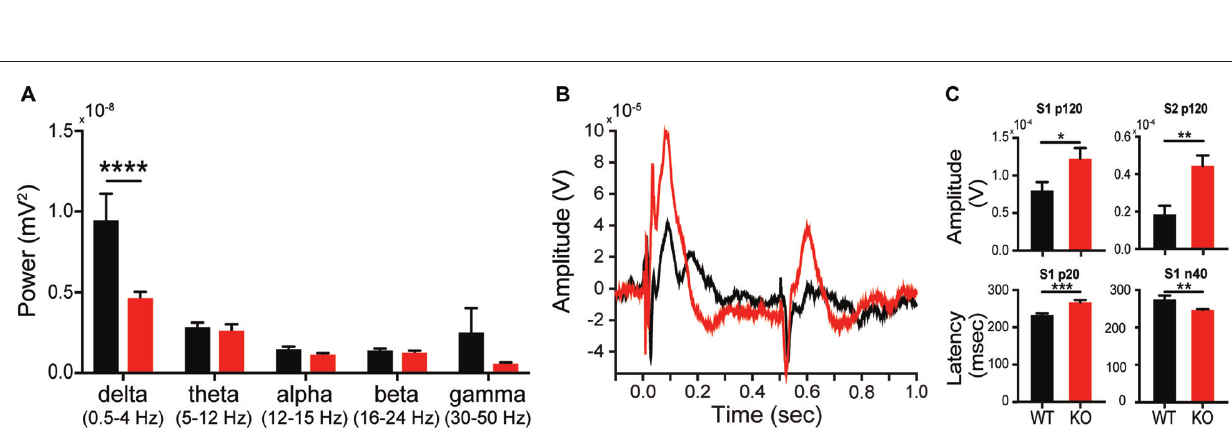
FIGURE 8 | Altered in vivo electrophysiology of the Shank2 KO rat. Alterations in neural responsiveness can be seen in vivo . KOs exhibit a reduction in spectral power in the delta frequency compared to WT animals during resting state conditions (A) . KOs have an altered evoked response to paired auditory stimuli (B) , with an increase in p120 amplitude and an increase in the latency of the p20 and n40 components of the cortical neural response (C) . In all panels WT animals are in black and KO animals are in red. Bars indicate SEM. ∗ p < 0.05, ∗∗ p < 0.01, ∗∗∗ p < 0.001, ∗∗∗∗ p <